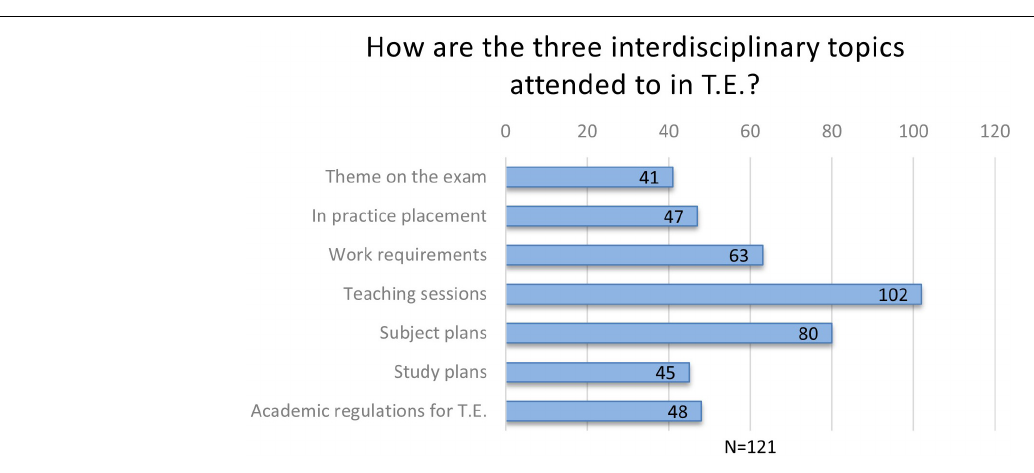
FIGURE 3 | Teacher educators’ report on how the three interdisciplinary topics are attended to in teacher